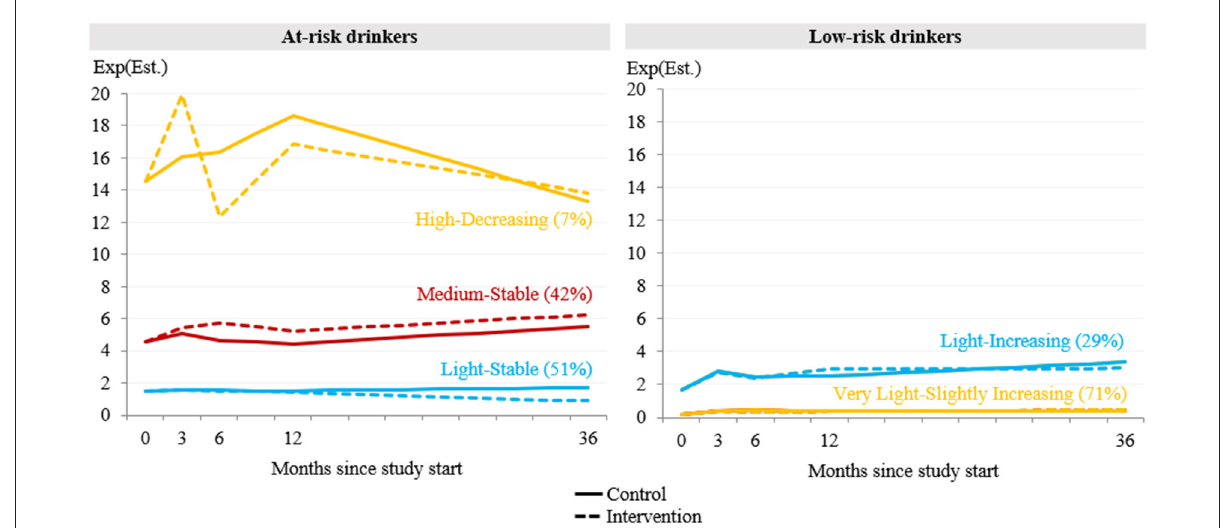
FIGURE4 Jointly estimated mean trajectories of drinks per week over 3 years for the control and the intervention group ( N = 1638). Est, Estimate.